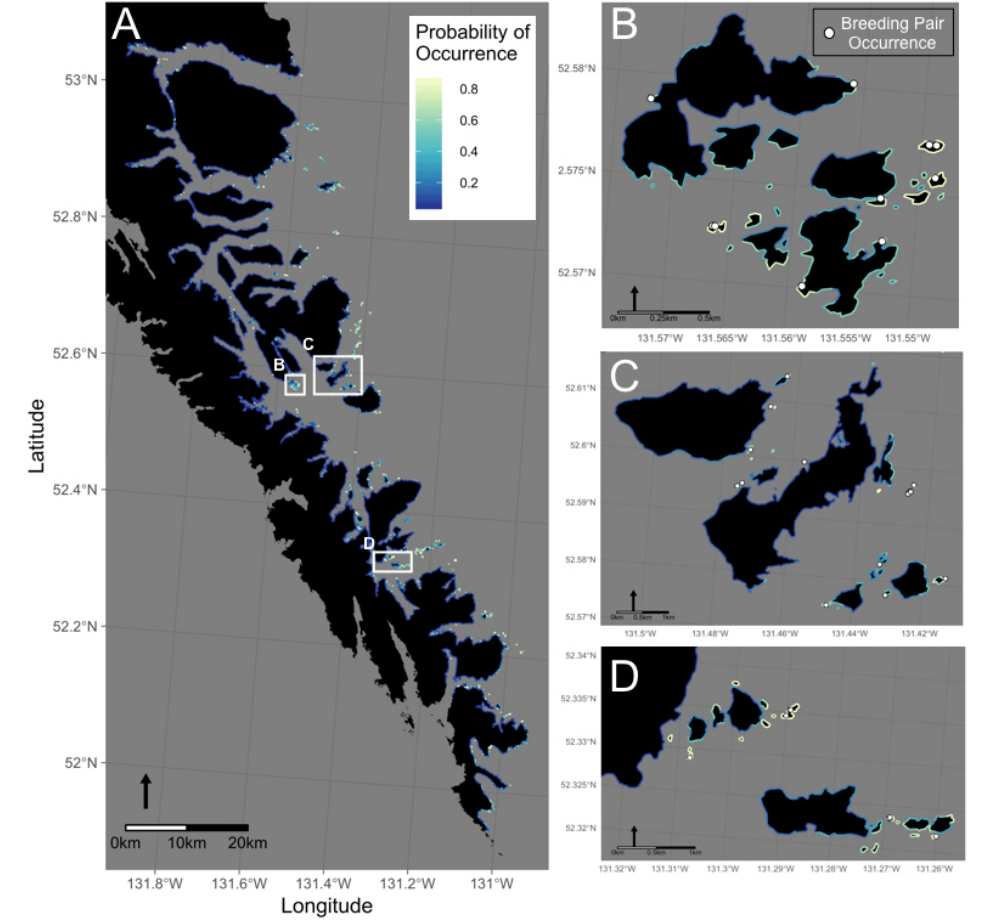
Fig. 4 . Predicted probability of occurrence of breeding pairs in southeastern Haida Gwaii. Insets show locations of observed breeding pairs (white points) relative to predicted probability of occurrence at sites of interest (Bischof Islands, Panel B; Murchison and Faraday Islands, Panel C; Swan and Bolkus Islands, Panel